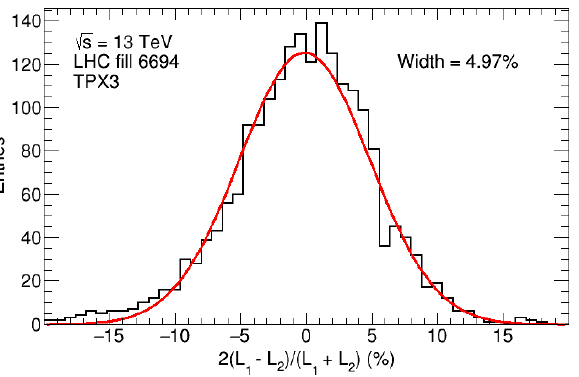
Figure 72. Gaussian fit of the relative difference between the TPX3 luminosities per bunch crossing measured by layers 1 and 2. The data are integrated over LHC fill 6694. Taken from Ref. [18].